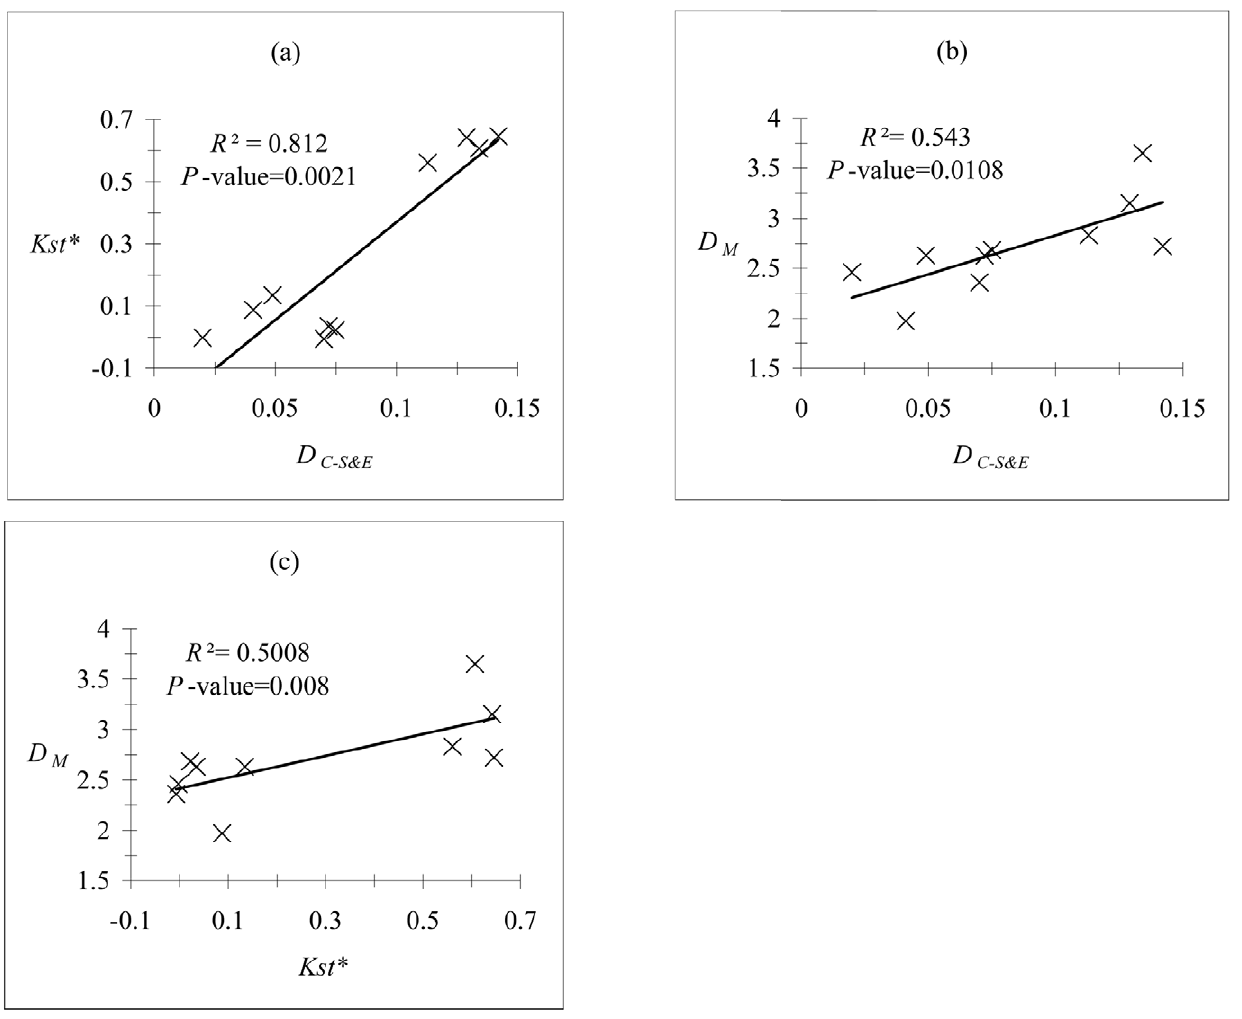
Figure 5. Mantel correlation tests ( P -values) between the different markers used in this study. Mantel correlation tests and percentages of variance explained ( R 2 ) between (a) Cavalli-Sforza and Edwards ( D C-S&E ) computed from microsatellite data and Kst* computed from COI mitochondrial data, (b) D C-S&E and Mahalanobis distance ( D M ) computed from morphometric data, and (c) Kst* and D M , for tsetse flies from the five different samples from Senegal (10